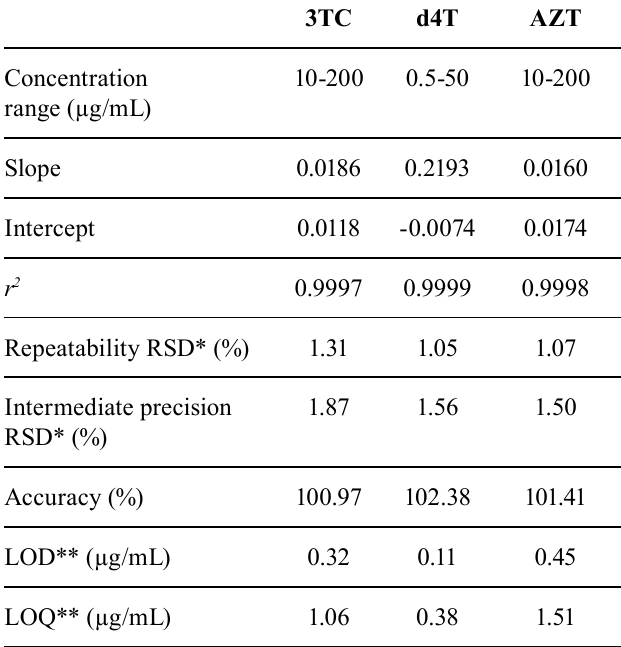
TABLE II – Results of the RP-HPLC method validation for antiretroviral drugs 3TC, d4T, and